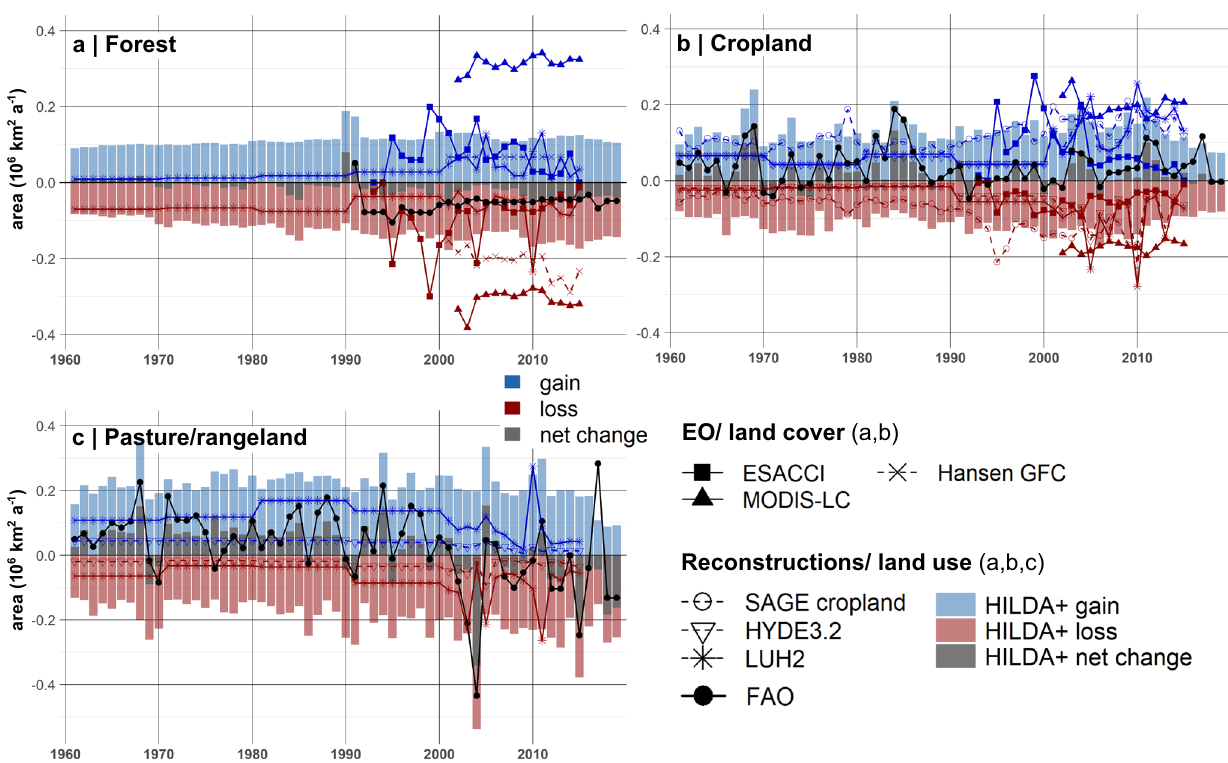
Fig. 4 Comparison of forest, cropland and pasture/rangeland changes. Global comparison of annual change of a forest, b cropland and c pasture/ rangeland ( c ) (gain, loss and net change area per year) from HILDA + , different Earth observation (EO)-based land cover datasets (ESA CCI 67 , MODIS- LC 68 , Hansen GFC 66 ), land use reconstruction models (SAGE cropland, update from 15 ), HYDE3.2 13 , LUH2 14 ) and FAO land use statistics 41 .